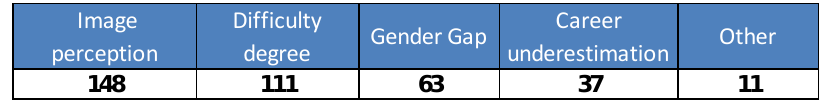
Table 3. Reasons to reject CS studies in university in number of answers. No representative information was obtained when separating the two targets (CS and other careers) therefore the answers to this question represent 100% of the responses)